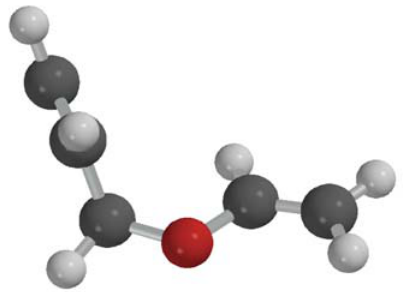
Figure 4. Bow-like structured AVE obtained in the IRC